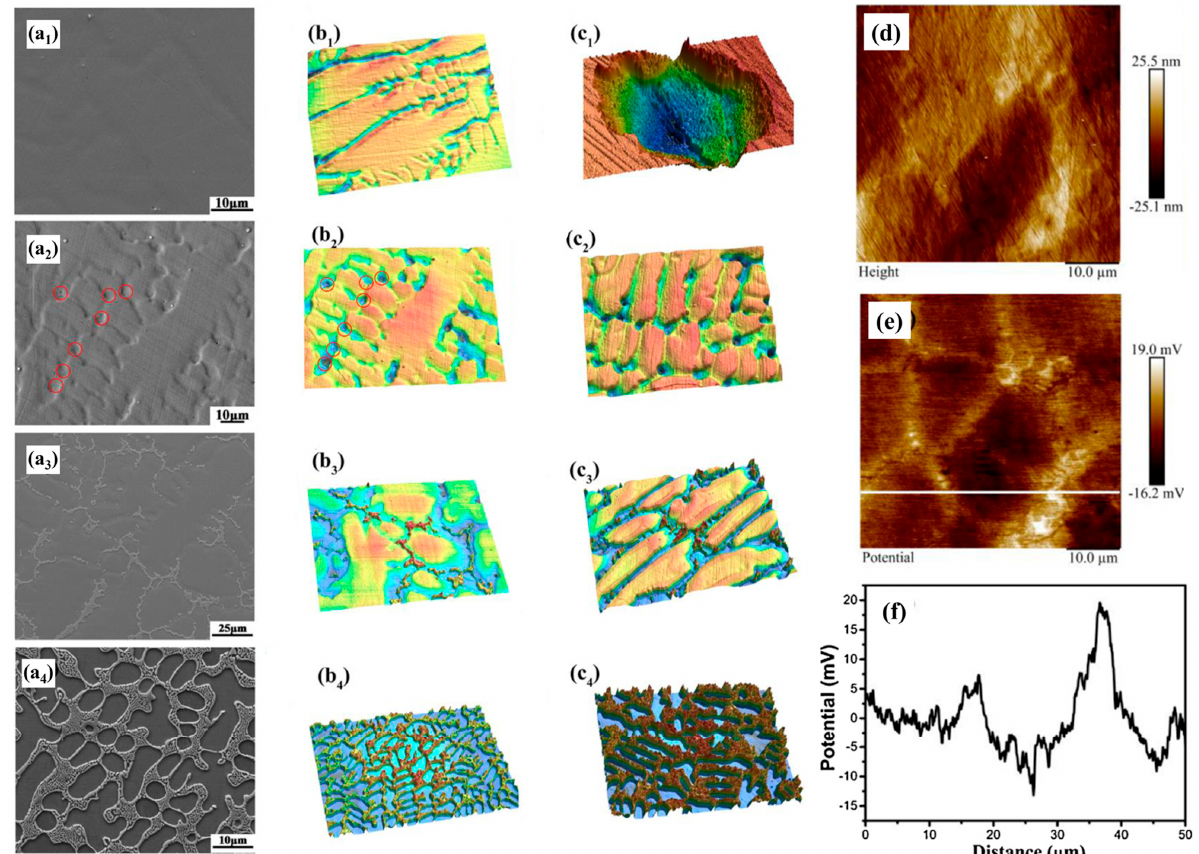
Figure 10. SEM morphologies and 3D characterizations of the FeCoCrNiMo x ( x = 0, 0.1, 0.3, 0.6) alloy after the anodic polarization in 1 M NaCl aqueous solution: ( a 1 – c 1 ) FeCoCrNiMo 0 alloy, ( a 2 – c 2 ) FeCoCrNiMo 0.1 alloy in which the red circles are the regions of the anodic dissolution, ( a 3 – c 3 ) FeCoCrNiMo 0.3 alloy, and ( a 4 – c 4 ) FeCoCrNiMo 0.6 alloy. ( a 1 – a 4 ) and ( b 1 – b 4 ) SEM and 3D images after anodic polarization for 600 s; ( c 1 – c 4 ) 3D images after anodic polarization for 1800s; ( d ) topographical, ( e ) potential distribution mapping of the FeCoCrNiMo 0.3 alloy and ( f ) line-scanning results of the white line in ( e ) [41].